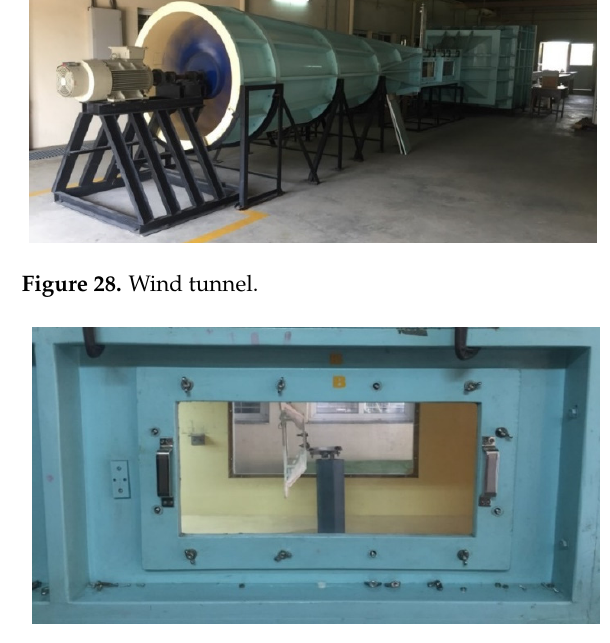
Figure 29. Test section with model. Table 15. Wind tunnel specifications.